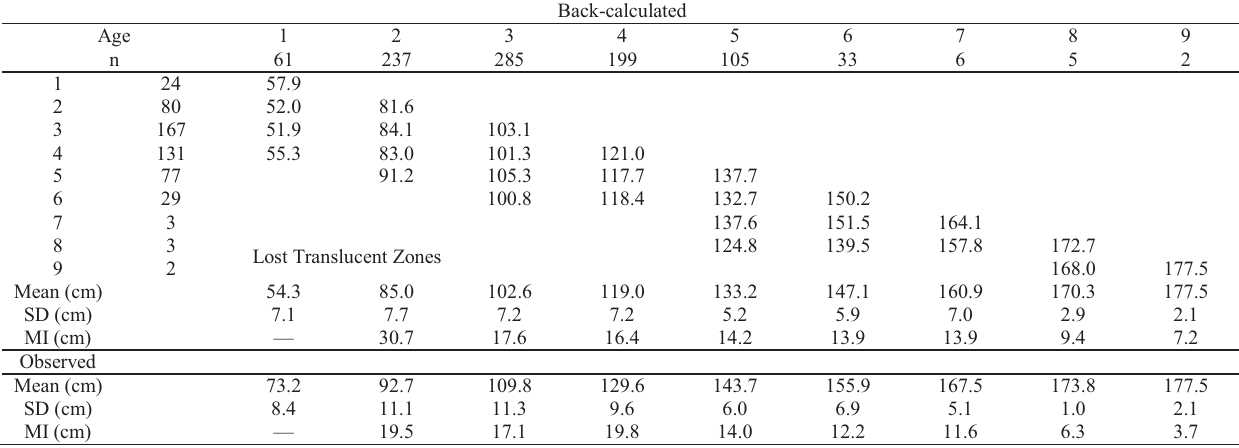
Table 2. Mean and standard deviation (SD) of back-calculated and observed length-at-age for bigeye tuna, T. obesus , caught in northeastern Brazil. MI is the mean increment between